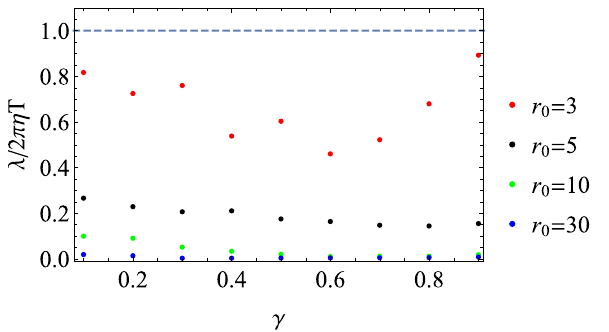
Fig. 7 ThemaximumLyapunovexponent λ/ 2 πη T fordifferent γ with various r 0 . The dotted line is the MSS